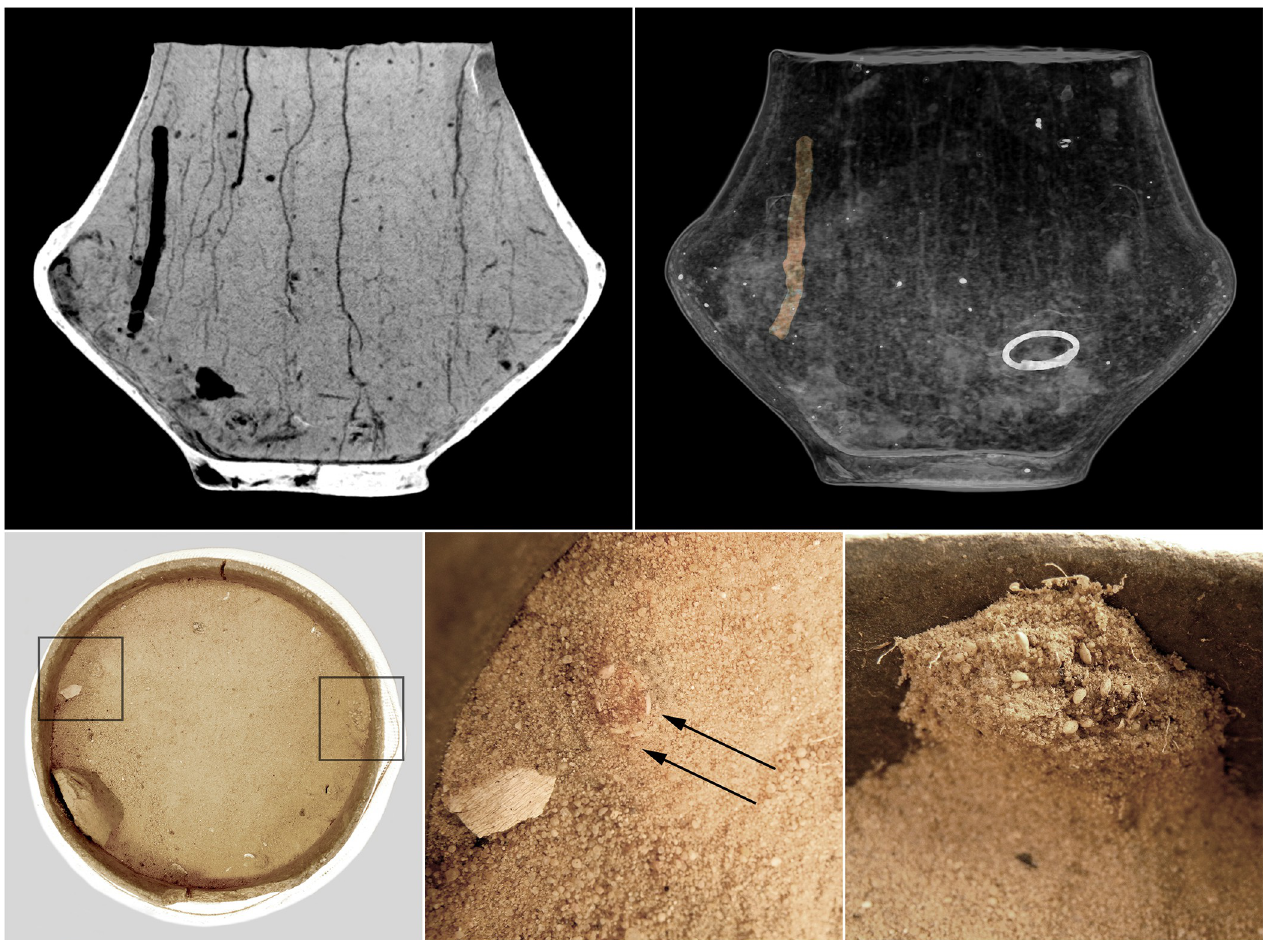
Fig 15. The CT imaging of the fill of the urn from grave 599. At the top, the MinIP and MIP reconstructions of the urn with a visible corridor of an insect of the genus Harpalus sp. At the bottom, the location of the corridor filled with Setaria sp . caryopses and the caryopses deposit identified during the spit exploration of the